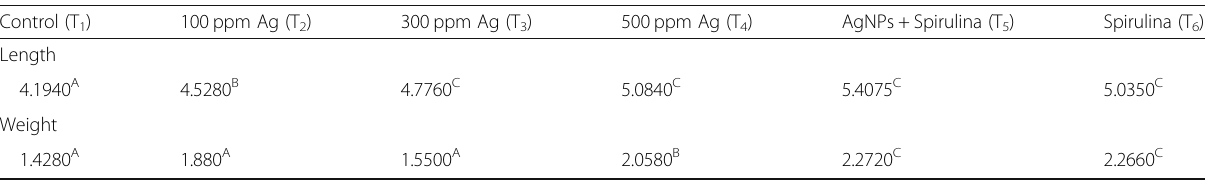
Table 3 DMRT analysis of silkworm Bombyx mori on growth rate Control (T 1